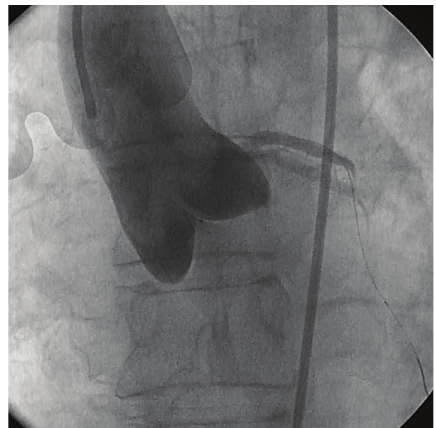
Figure 2: Repeat aortogram showing no aortic mass and improved coronary perfusion with bare metal wire in situ in the left coronary artery.